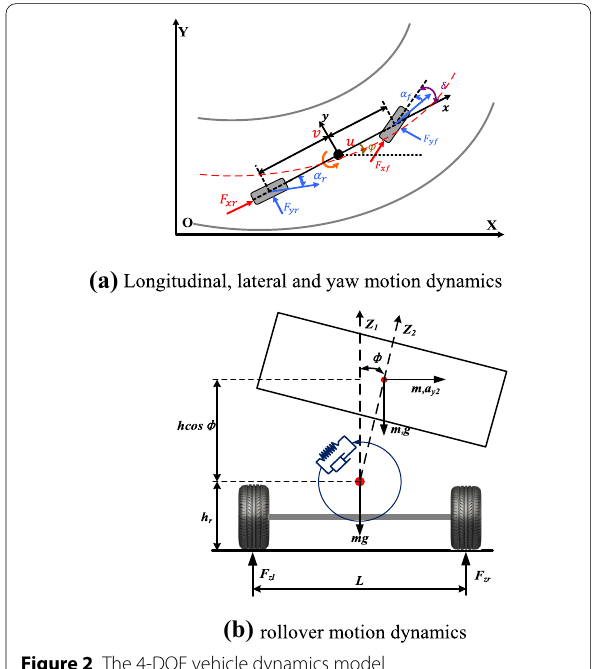
Figure 2 The 4-DOF vehicle dynamics